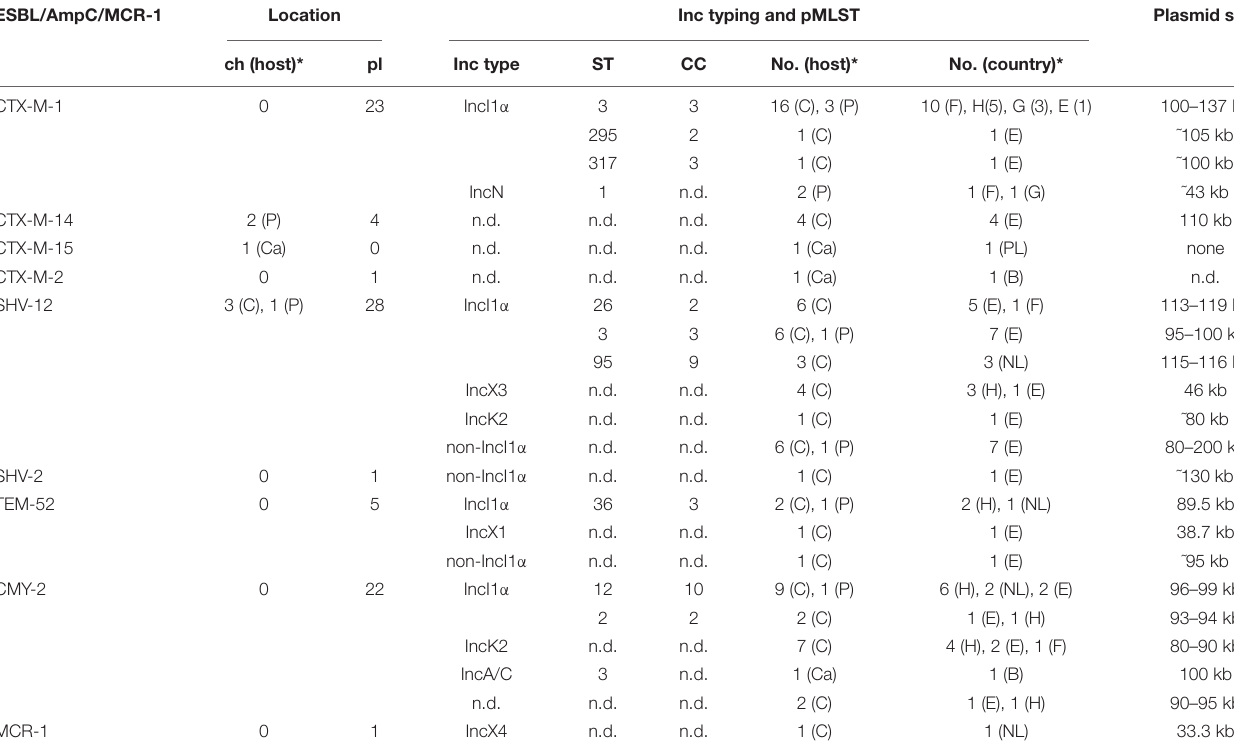
TABLE 2 | Genomic location of ESBL/AmpC and MCR-1 genes and assignment to Inc